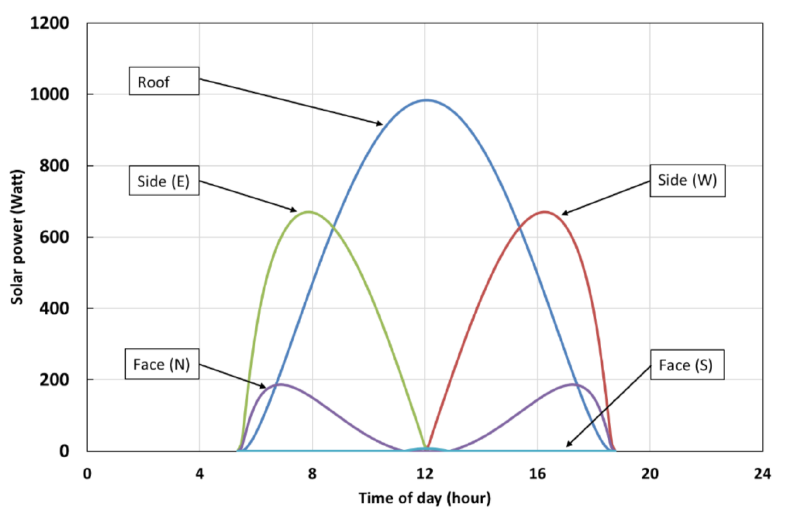
Figure 6. Solar radiation incident on the walls of the container over a summer’s day. Side (E) indicates the container side wall normal to the east, Side (W) indicates the container side wall normal to the west, Face (N) indicates the container face wall normal to the north, Face (S) indicates the container face normal to the south, and Roof indicates the roof wall of the container, which is normal to up. It must be noted that the most solar radiation is received on the roof of the container and then each side in turn. The north-pointing face receives up to 20% of the maximum value of the solar radiation the roof is exposed to. The incident solar radiation the container walls are exposed to changes significantly during wintertime, when the solar elevation angle is significantly reduced, as shown in Figure 7.